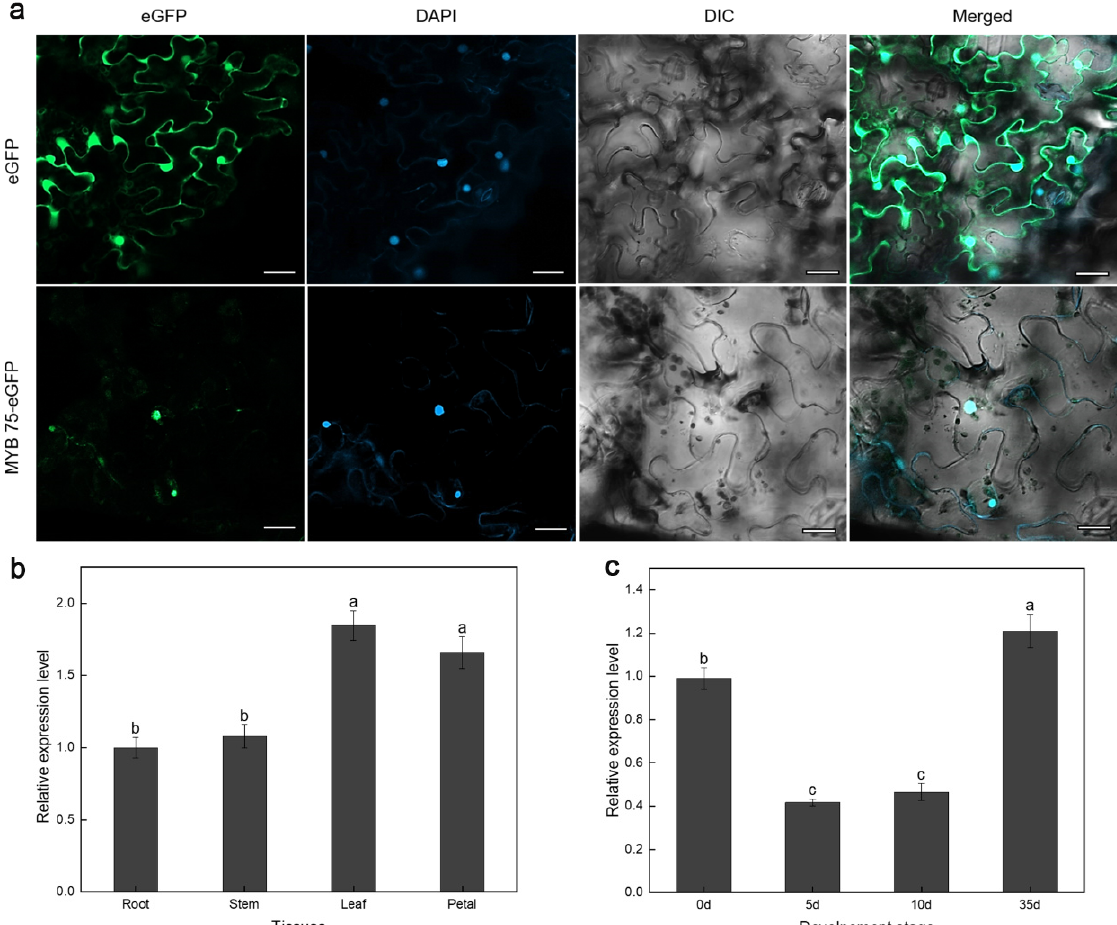
Figure 5. Subcellular localization and expression patterns of the LiMYB75 gene. ( a ) The green fluorescent protein LiMYB75 signal was localized in the nucleus by laser confocal observation during instantaneous expression in tobacco ( Nicotiana benthamiana ) leaf epidermal cells using Agrobacterium tumefaciens. The nuclei of N. tabacum epidermal cells were stained with 4 ′ ,6-diamidino-2-phenylindole (DAPI). Scale bars = 20 μ m. ( b ) There was no difference in the expression of LiMYB75 between petal and leaf ( c ) The spatiotemporal expression pattern analysis found the highest gene expression in the shoot regeneration stage. The four stages of the development process of leaf callus induction and regeneration were callus activation (0 days after cutting, DAC), callus formation (5 DAC), callus expansion (10 DAC), and shoot regeneration (35 DAC). The real-time quantitative polymerase chain reaction data were normalized using the internal control expression of LiEf α . The error bars represent the standard deviation of expression from three independent biological replicates. The 2 − ∆∆ Ct method was used to evaluate the quantitative variation between replicates. Different lowercase letters indicate significant differences at p < 0.05.